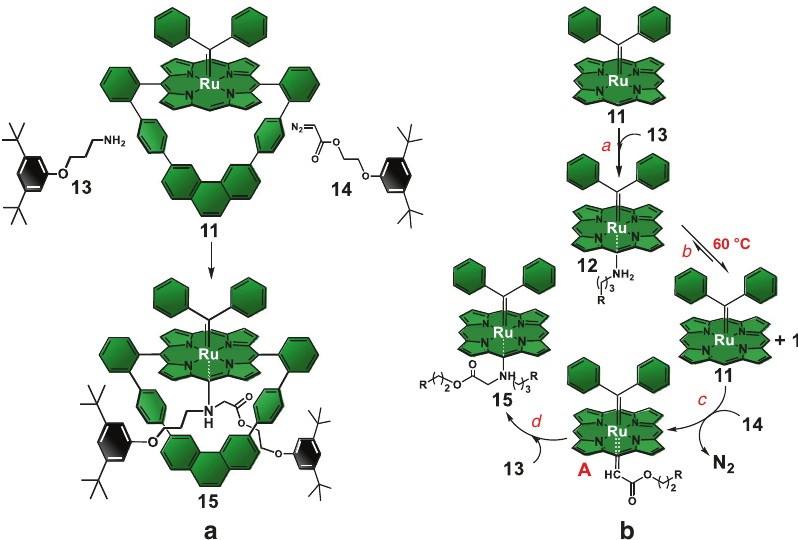
Fig. 6 Operation of the nanoreactor. a Synthesis of asymmetrical [2]rotaxanes by the active-metal template technique based on the Ru(II)porphyrinate- promoted N-H carbene insertion reactions. Experimental conditions: benzene, 8 h, N 2 atmosphere, quantitative yield relative to 11 . b Conceivable reaction mechanism for the carbenoid N – H insertion process promoted by the Ru(II)porphyrinate subunit in 11 that quantitatively yield asymmetrical [2]rotaxane 15 through the active-metal template technique. The aromatic loop in 11 is not shown in the mechanism for clarity purposes. R = 3,5-di- tert -butylphenoxy stopper